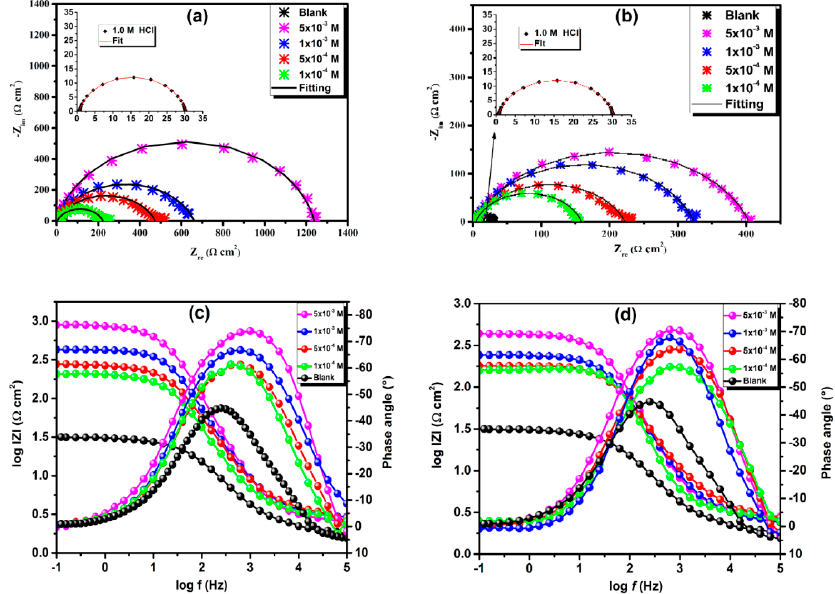
Figure4. Figure 4. Nyquist and Bode diagrams of mild steel in 1.0 M HCl with and without various concentrations: ( a,c ) MPH and ( b,d ) BPH.